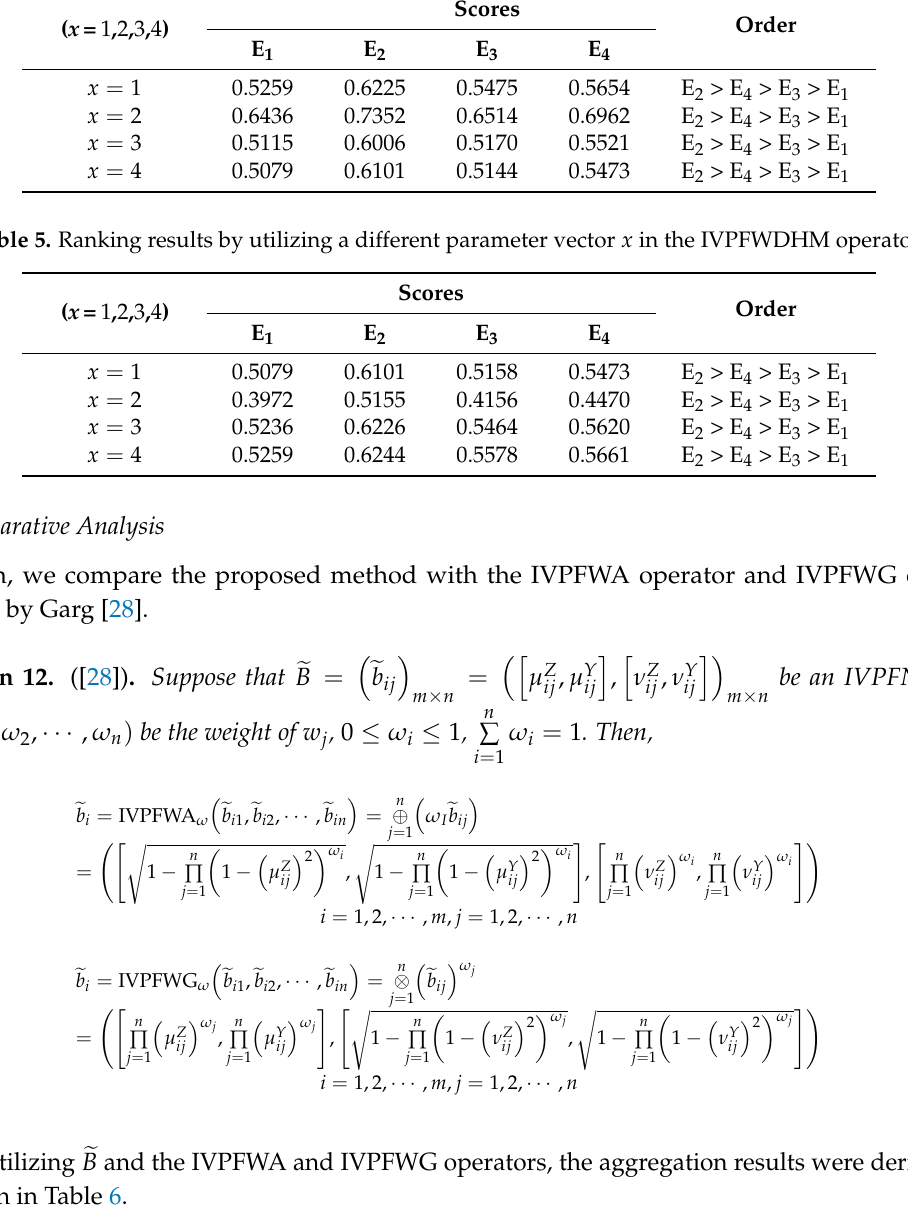
Table 6. The aggregation results of green suppliers by the IVPFWA (IVPFWG)